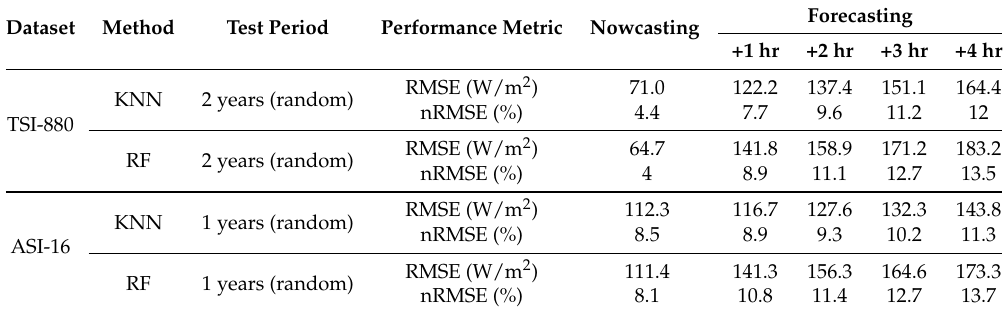
Table 2. Root mean square error (RMSE) and normalized root mean square error (nRMSE) for nowcasting and forecasting results using the proposed